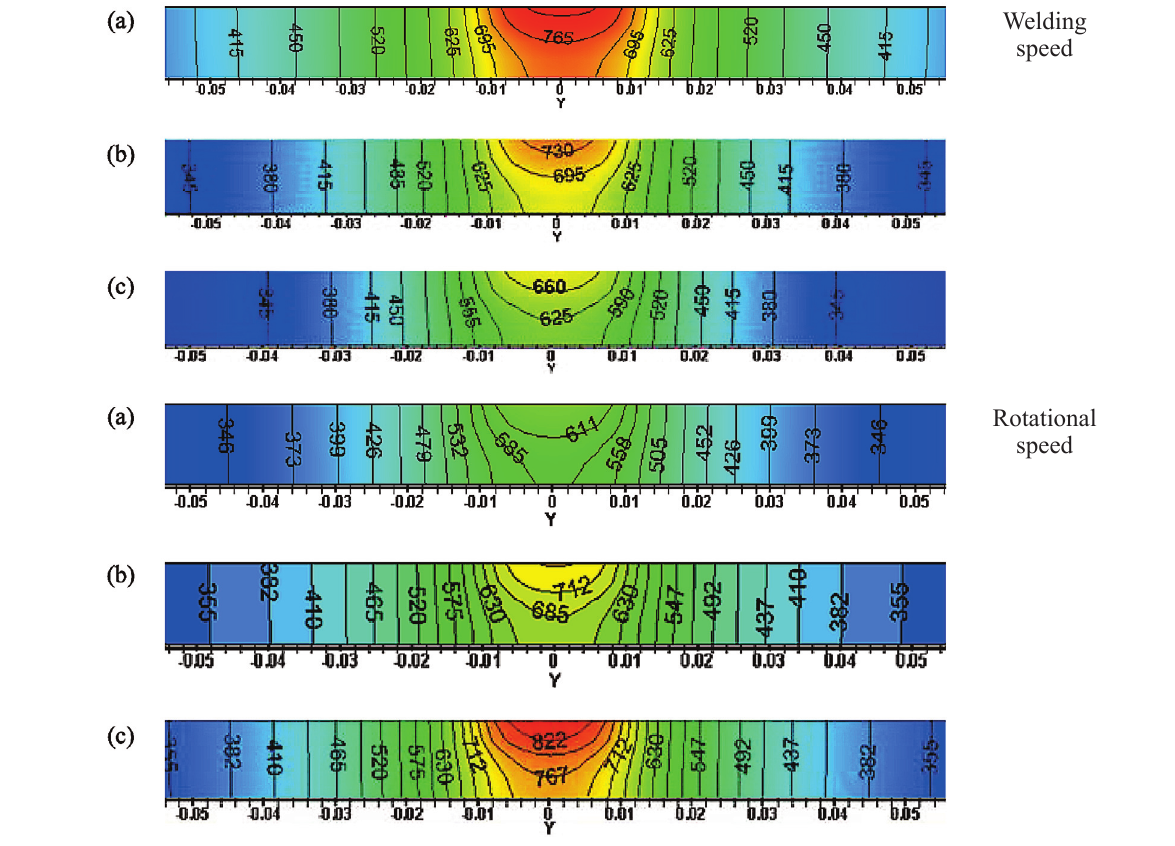
Fig. 4. Effect of welding speed and rotational speed on the temperature field in the plane perpendicular to the welding line: (a) 1.5 mm/s, (b) 3.0 mm/s, (c) 4.5 mm/s ((a) 300 tr/min, (b) 400 tr/min, (c) 500